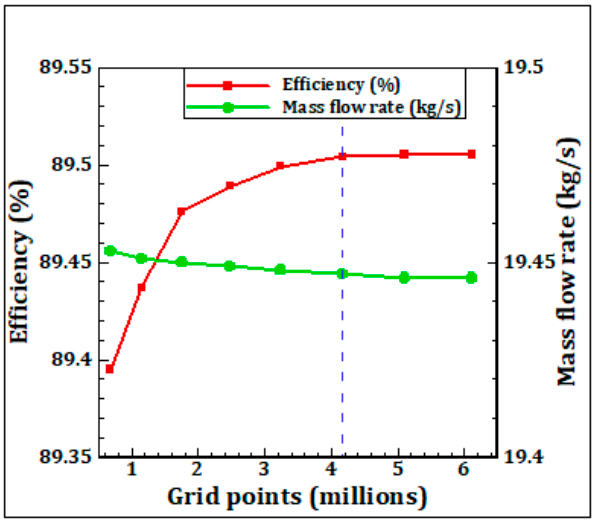
Start Point: Design objectives, datum design, geometrical and aerodynamic boundary condition spaceObjective function